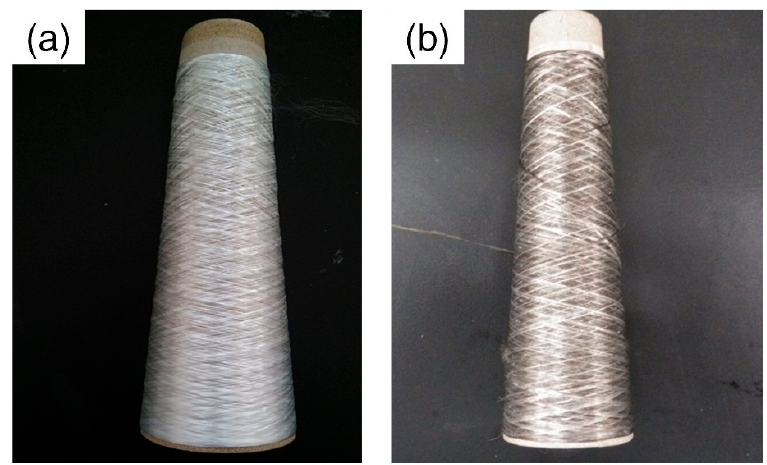
Figure 10. Photographs of winding bobbins of polyester fibers: ( a ) before silver plating; ( b ) after silver plating.